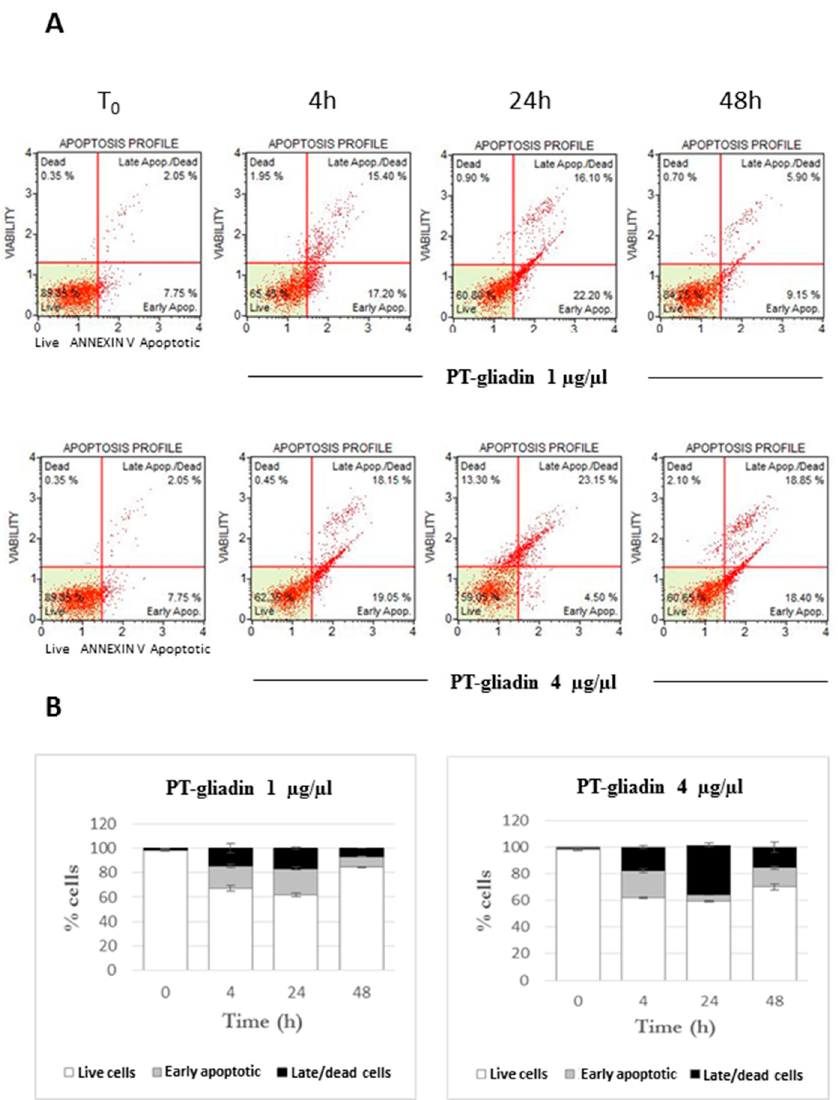
Figure 6. Viability assays after PT-gliadin administration in Caco-2 cells. ( A ) Cytofluorimetric plots of viability profiles (L: cells live; D: cells death) summarized in Panel ( B ) (asterisk indicates p < 0.05, Anova One-way, compared to T 0 untreated sample).